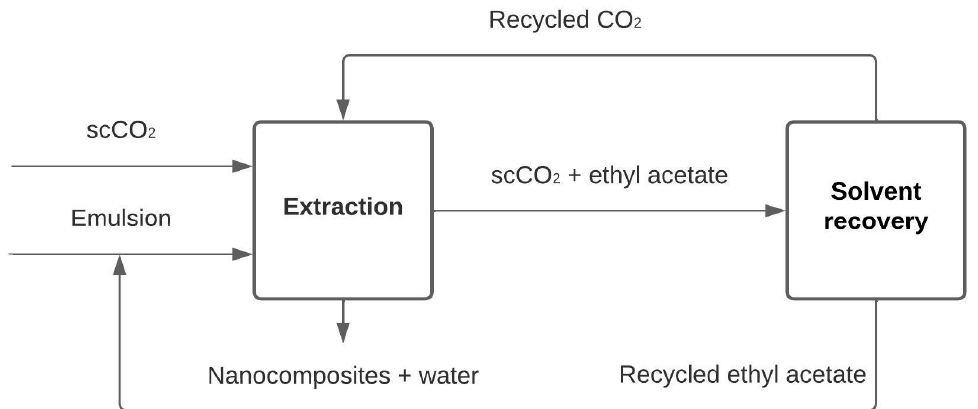
Figure 1. Block diagram of the supercritical fluid extraction of emulsion (SFEE) process.